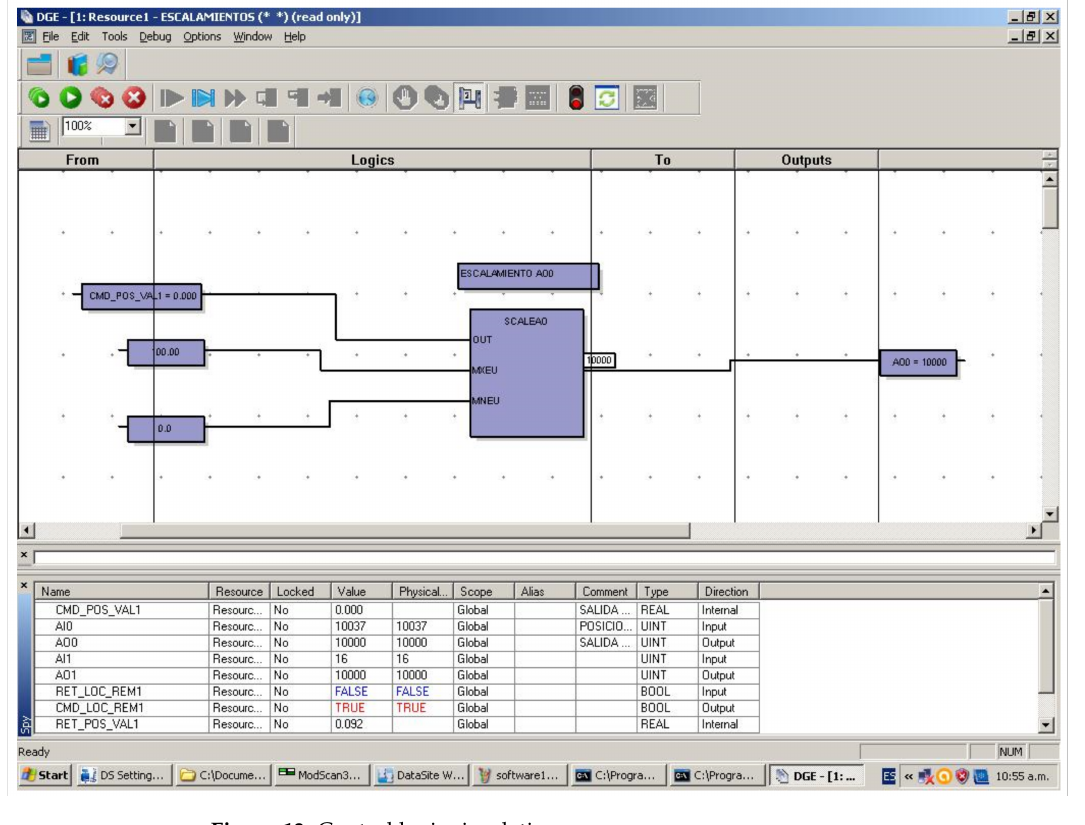
Figure 13. Control logic simulation.